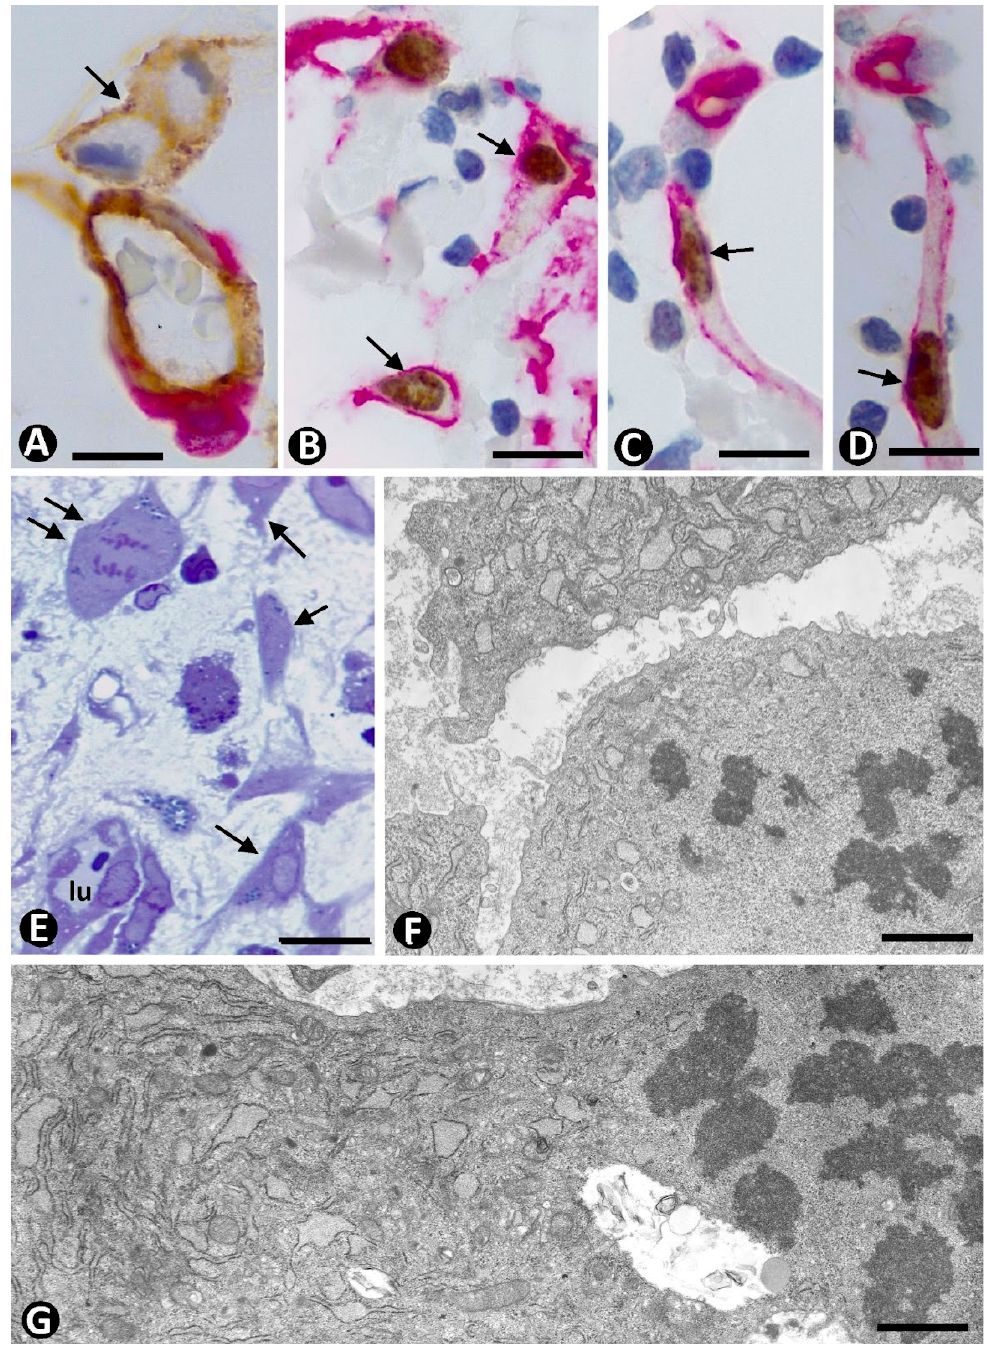
Figure 5. Mitosis and high proliferative index in stromal cells during sprouting angiogenesis. ( A ): A mitosis in telophase observed in a CD34+SC/TC around a vessel, in which endothelial cells (brown) and pericytes (red) are seen. ( B – D ): CD34+SCs/TCs (red, with peripheral expression of CD34) expressing anti-ki-67 (brown, with nuclear expression). ( E ): Hypertrophied stromal cells (arrows), one in mitosis (double arrow), around a vessel. ( F , G ): Ultrastructural characteristics of stromal cells in mitosis. Note the presence of chromosomes and abundant endoplasmic reticulum. Vessel lumen: lu. ( A ): Double immunochemistry staining for CD34 (brown) and α SMA (red). Hematoxylin counterstain. ( B – D ): Double immunochemistry staining for CD34 (red) and ki-67. Hematoxylin counterstain. ( E ): Semithin section. Toluidine blue staining. ( F , G ): Ultrathin sections. Uranyl acetate and lead citrate. Bar: ( A – D ): 30 µ m; ( E ): 12 µ m; ( F ): 1 µ m; ( G ): 0.8 µ